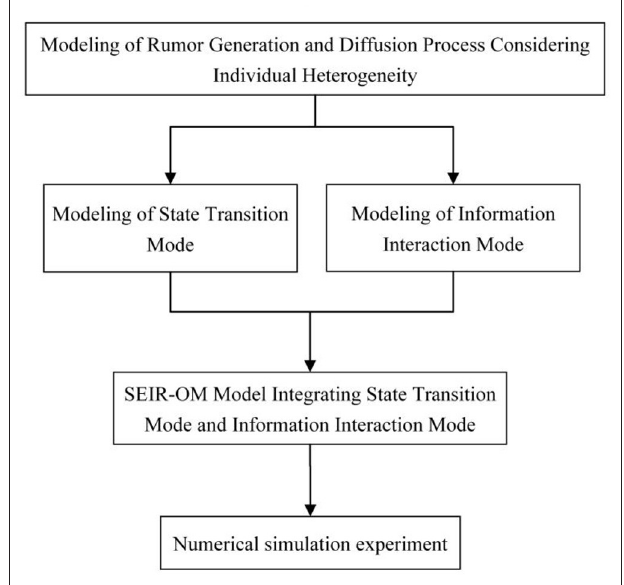
FIGURE 1 | Framework of this